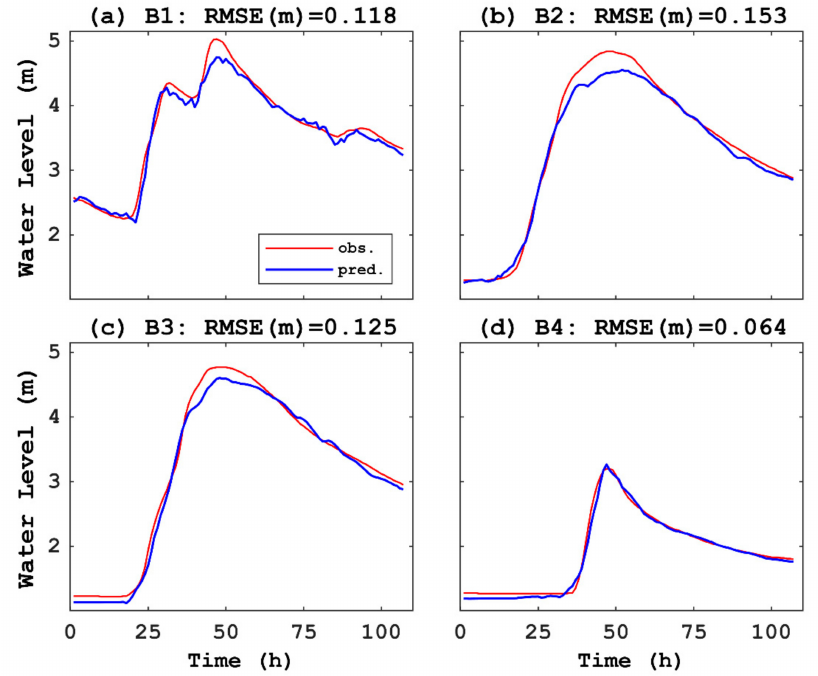
Figure 10. Comparisons between observed data (obs.) and prediction (pred.) in four test datasets for water level (m) versus time (hour) in Domain B, using CNN transfer learning with 20-time retrainings: ( a ) highest flood event, ( b ) second highest flood event, ( c ) third highest flood event, and ( d ) moderate peak flood